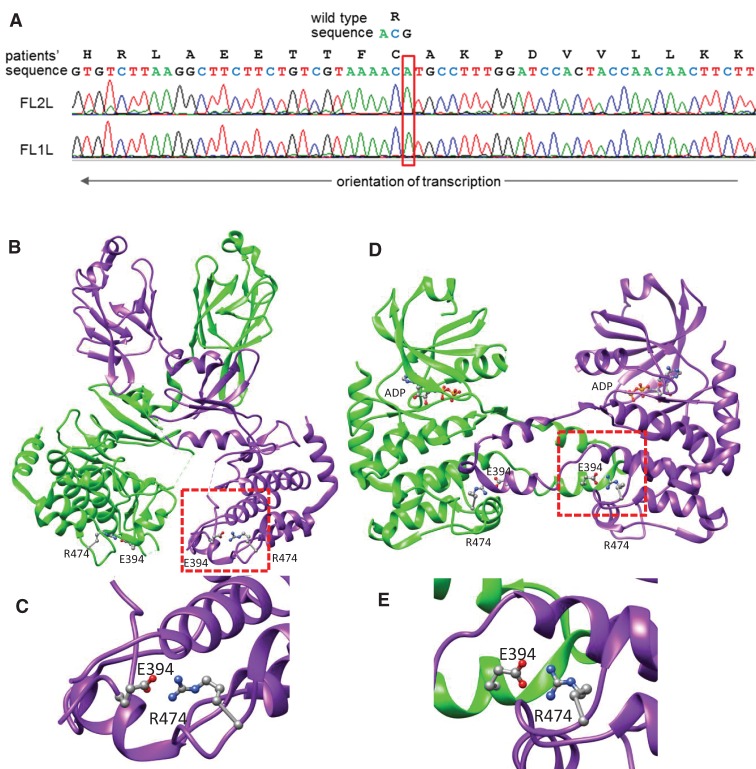
CHEK2 mutation. (A) Sanger sequencing of p.R474C mutation from patient siblings. (B) Structure of inactive CHK2 homodimer (PDB code: 3i6w). Most residues in the activation segment are disordered and invisible. (C) Enlarged view of the salt bridge between p.R474 and p.E394. (D) Structure of active CHK2 homodimer with ADP (PDB code: 2cn5). The activation segment is visible and swapped. (E) Enlarged view of the interchain salt bridge between p.R474 and p.E394. The molecular graphics were generated with UCSF Chimera (Pettersen et al. 2004).